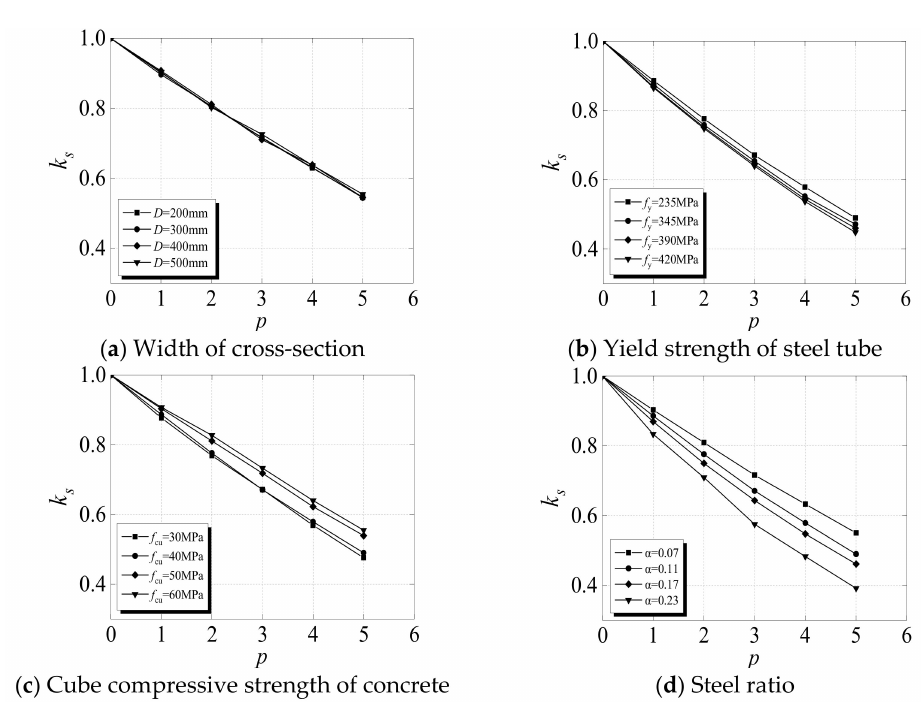
Figure 14. Influences of di ff erent parameters on K s (defined as the influence factor of the bearing capacity of SCFST columns after axial compression and exposure to the combined action of freeze–thaw cycles and acid rain corrosion) of the